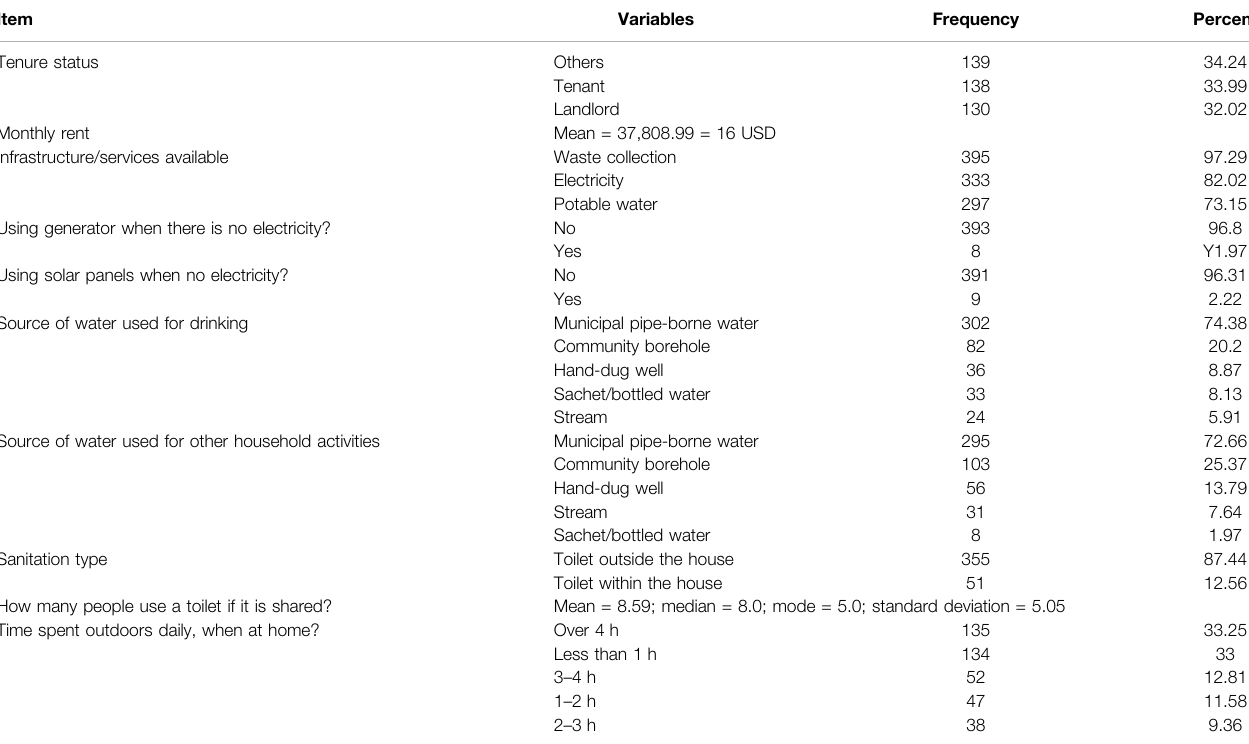
TABLE 2 | Housing characteristics of